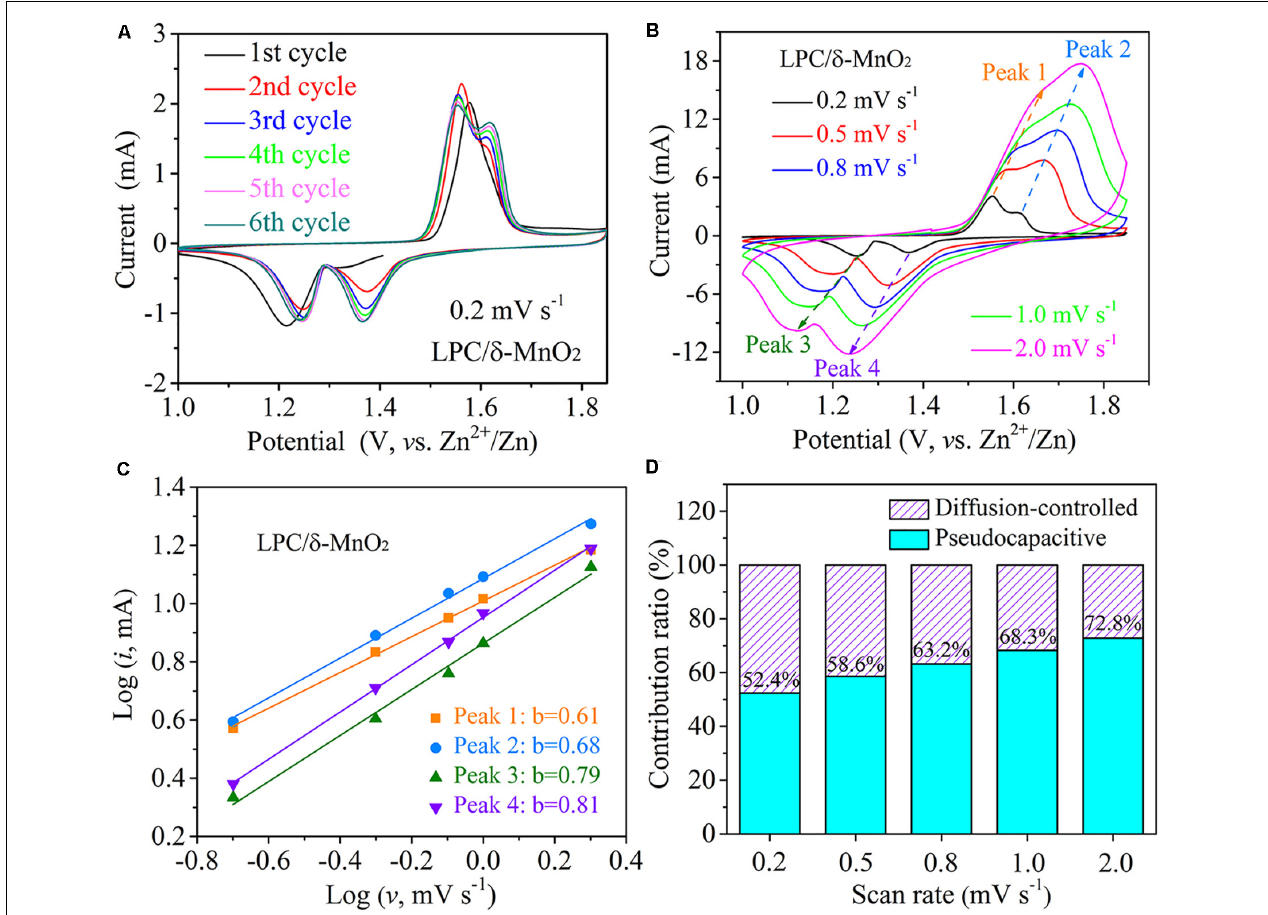
FIGURE 4 | (A) CV curves of LPC/ δ -MnO 2 in initial six cycles at 0.2 mV s - 1 . (B) CV curves of LPC/ δ -MnO 2 at scan rates from 0.2 to 2.0 mV s - 1 . (C) Log ( i ) vs. log ( ν ) for different redox peaks in the CV curves. (D) Contribution ratios of diffusion-controlled and pseudocapacitive capacities of LPC/ δ -MnO 2 at different scan rates.